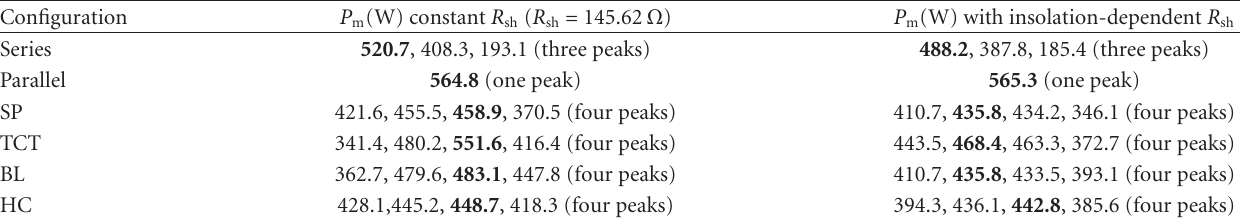
Table 1: Comparison of power with and without the e ff ect of insolation-dependent R sh .